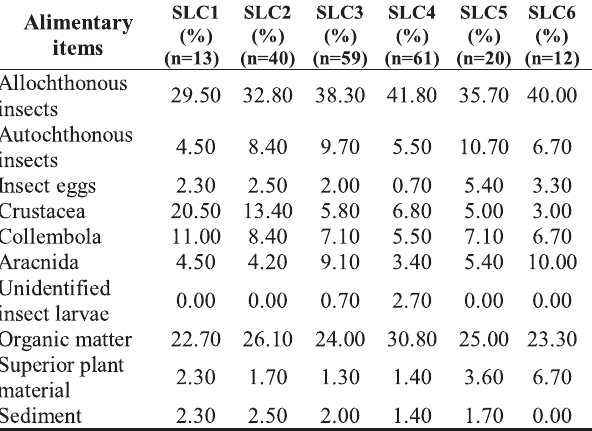
Table 4. Percent composition of dietary items found in stomachs of Mimagoniates rheocharis for standard